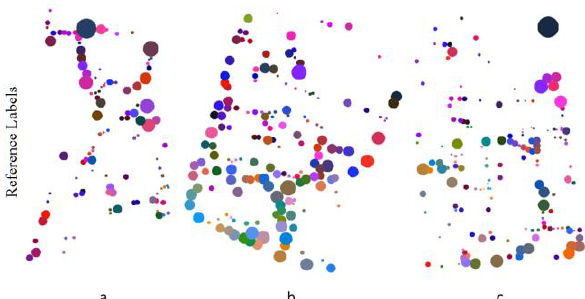
Figure 6. Reference labels used to evaluation. a) Area1, b) Area2 and c) Area3